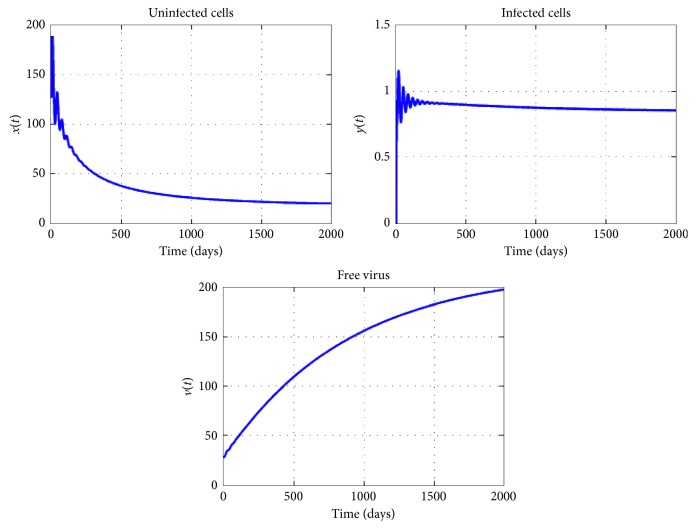
Dynamics of virotherapy when R0=0.7, β0=10−3, β1=10−5, β2=2 × 10−5, β3=3 × 10−5, β4=4 × 10−5, τ1=0.2, τ2=1, τ3=2, and τ4=3. The initial conditions are x(0)=127, y(0)=0, and v(0)=30.